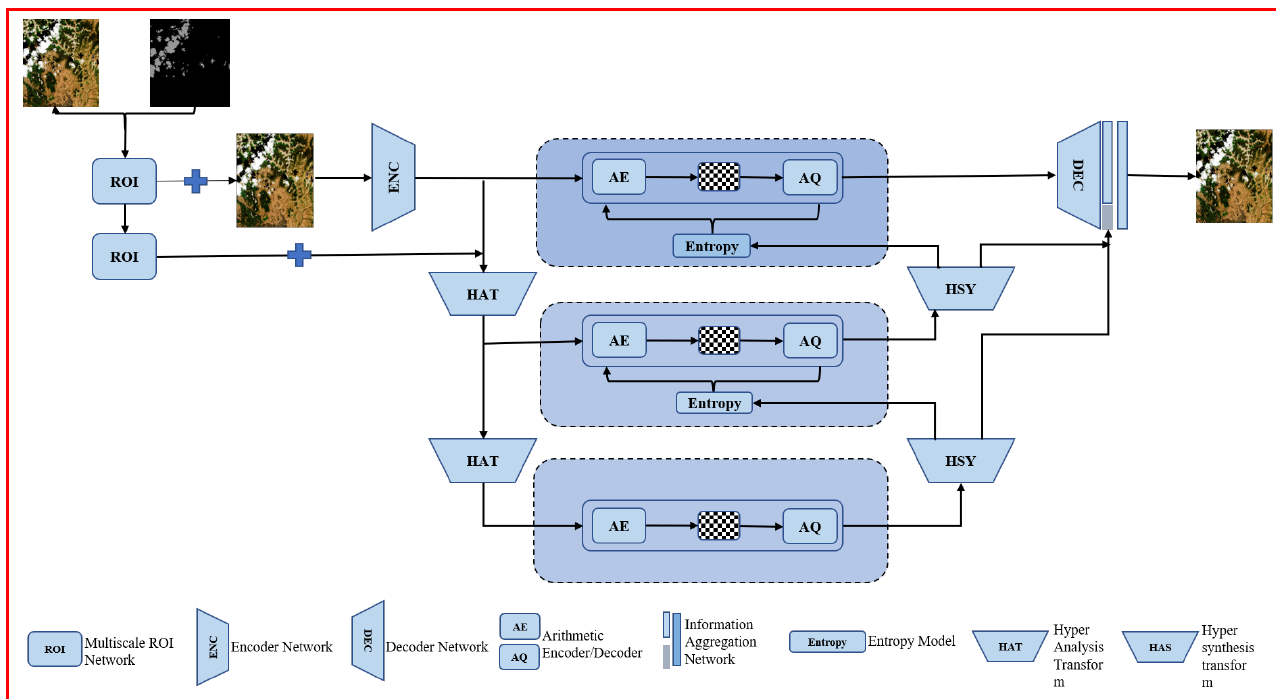
Figure 6. Image compression network structure based on multiscale region of interest attention module. (1) Adding uniform noise: The method of adding uniform noise was first used by Balle, as shown in Equation (8). Quantization can be achieved by adding uniform noise ) or the variable x during obeying U ( − 1 , 1 2 2